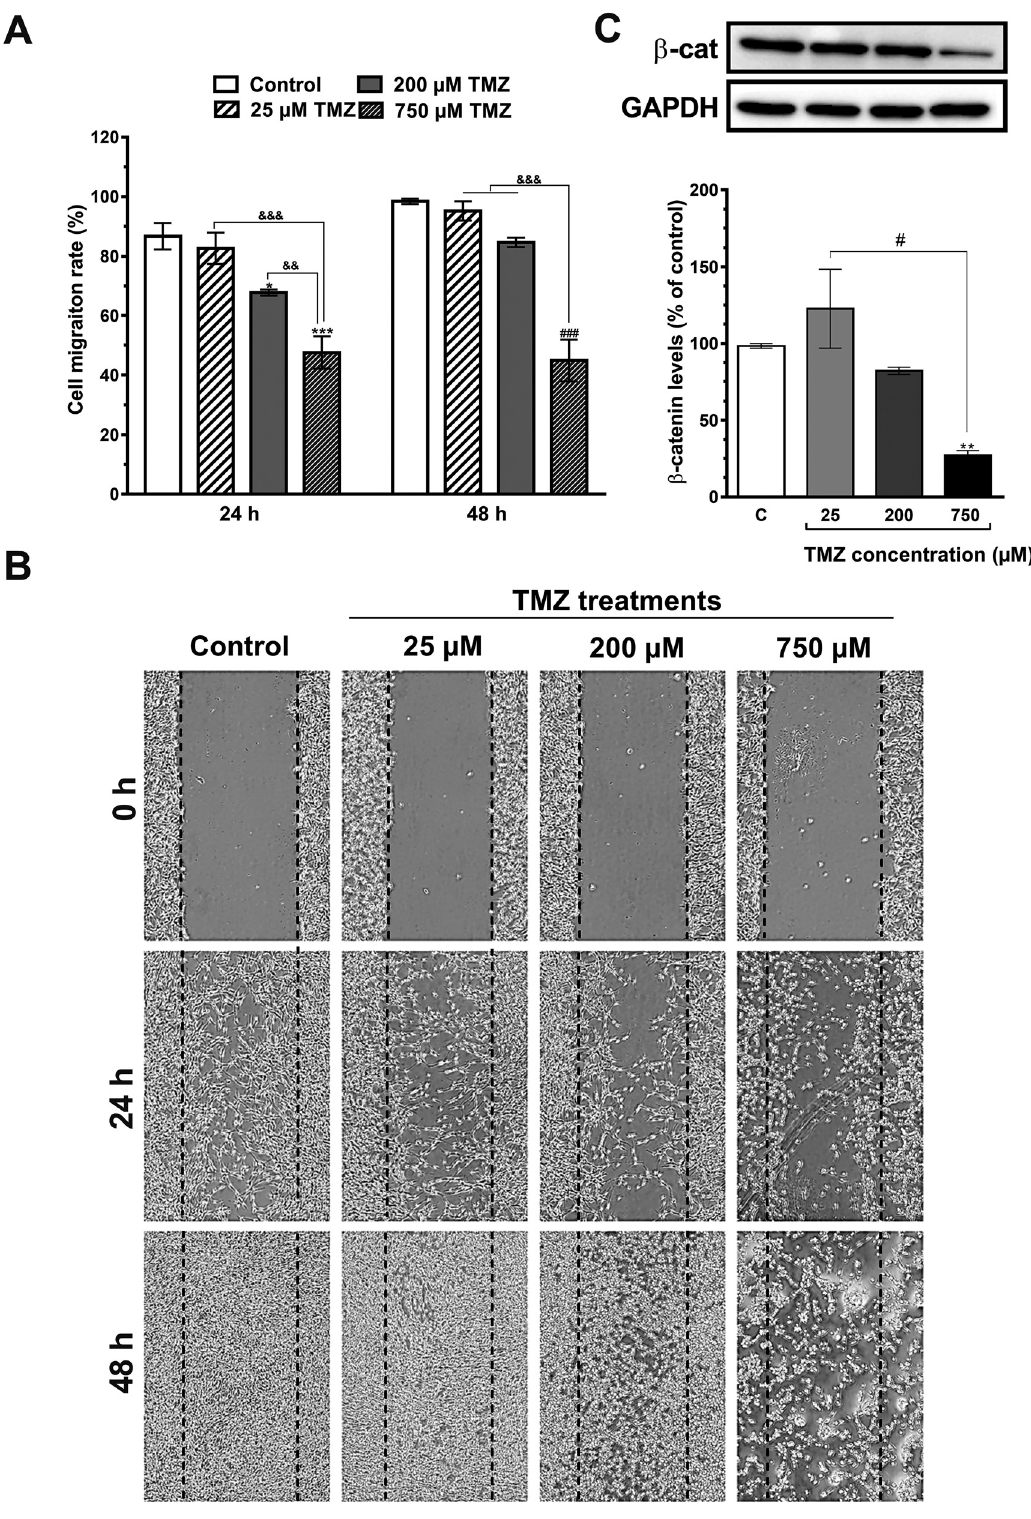
Figure 5: The effect of temozolomide (TMZ) on the cell migration ability. A) Cell migration rate (%) was determined by in vitro scratch assay. Vertical bars indicate standard deviation values. *p<0.05 and ***p<0.001 vs. control group for 24 h, ###p<0.001 vs. control group for 48 h, &&p<0.01 and &&&p<0.001 indicates statistical difference between different groups B) Images of wounded monolayer of U87MG taken at times0,24and48haftertreatmentwithTMZ.C)Theexpressionof β -cateninofTMZtreatedcells.**p<0.01vs.controlgroup,#p<0.05indicate statistical difference between different